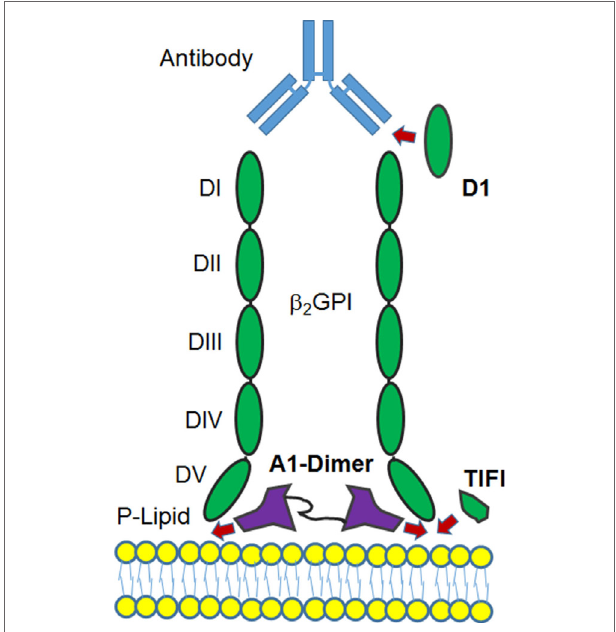
FigURe 2 | Diagram of potential sites where binding of β 2GPI to a phospholipid membrane may be disrupted. Recombinant versions of the D1, a portion of the DV domain (TIFI) or a dimer of the ApoER2 domain A1 are shown to indicate where the formation of the β 2GPI-anti- β 2GPI complex at the cell surface may be inhibited for therapeutic benefit. For details, see main